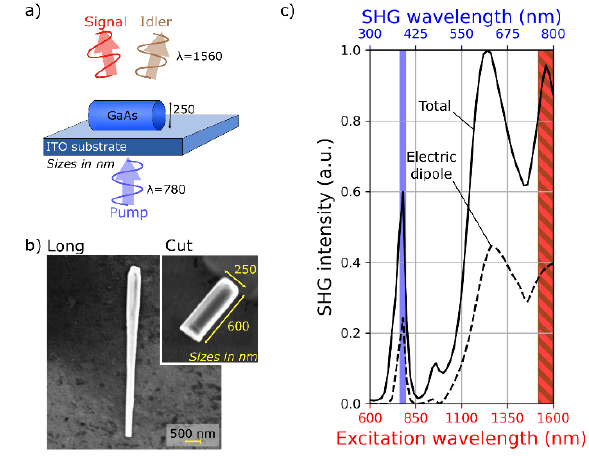
Figure 1. a) Schematic of the SPDC process for a GaAs nanowire pumped at 780 nm. b) Electron microscopy image of a nanowire before and after being sliced by focused ion beam milling. c) Simulation spectrum of second-harmonic generation (SHG), the reverse process of degenerate SPDC, for a sliced nanowire with a 600 nm length and a 250 nm diameter. The resonances are located around 780 and 1560 nm as set for the experiment, with a dominant electric dipole emission profile.